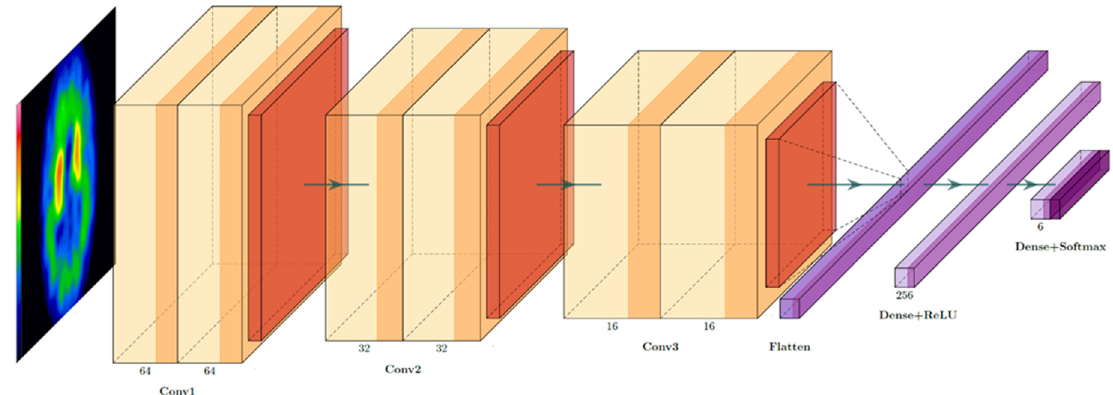
Figure 3. Architecture of SolaNet, our proposed